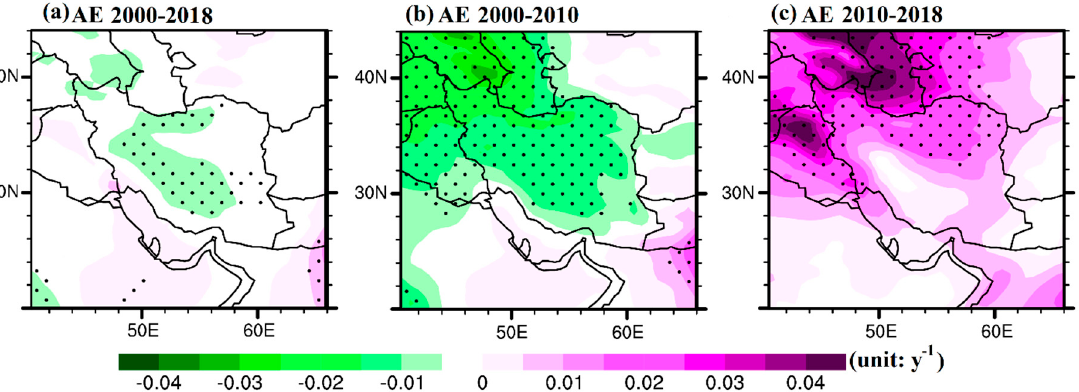
Figure 7. Spatial distributions of the winter (DJF) linear trends of the MERRA-2 AE data calculated from the anomalies during the periods 2000–2018 ( a ), 2000–2010 ( b ), and 2010–2018 ( c ). The black dots indicate that the trend is significant at a 95% confidence level ( p < 0.05).